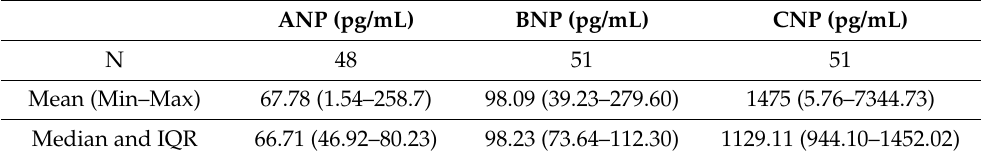
Table 2. Natriuretic peptide concentrations in plasma from cord blood.